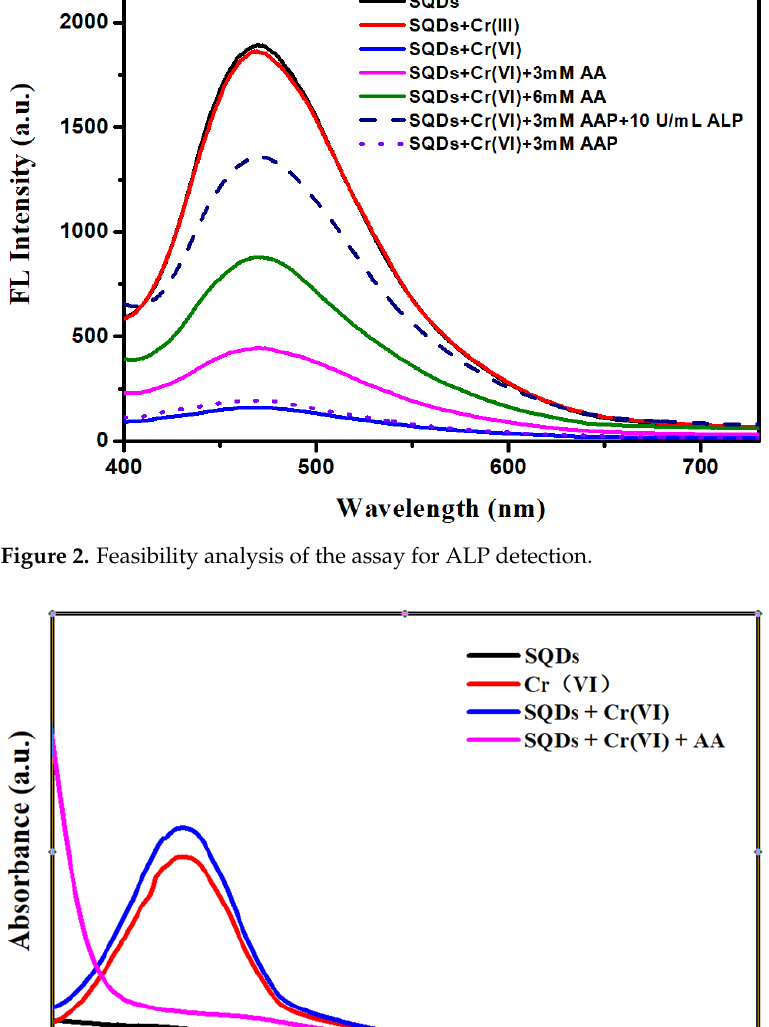
Figure 2. Feasibility analysis of the assay for ALP detection.